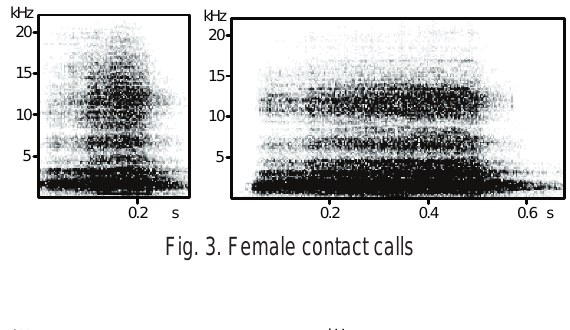
Fig. 3. Female contact calls